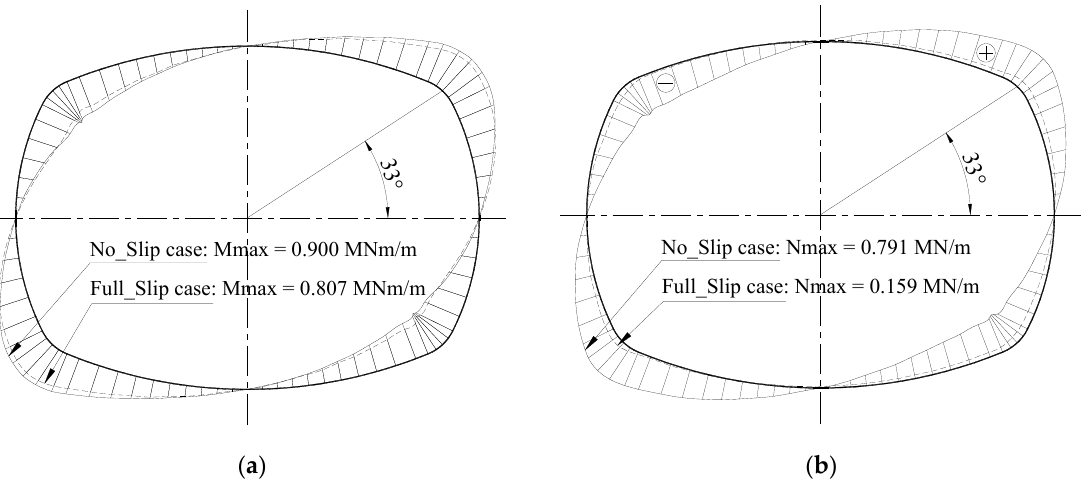
Figure 9. Distribution of the incremental bending moments and normal forces in the sub-rectangular tunnel. ( a ) incremental bending moment; ( b ) incremental normal forces.